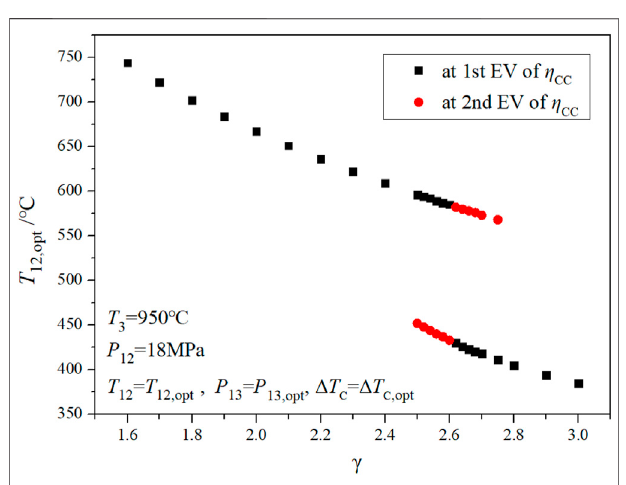
FIGURE 10 | Power ratios corresponding to the extreme values of combined cycle ef fi ciency.